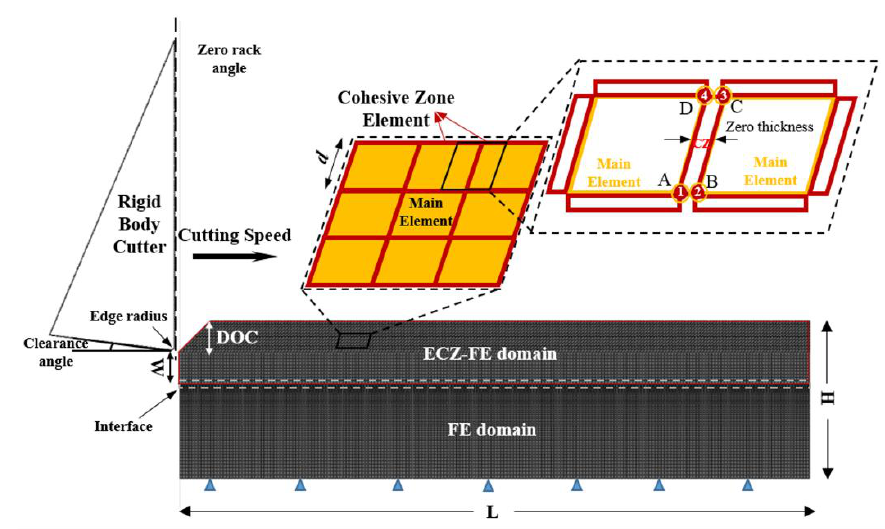
Figure 1. Schematic of embedded cohesive zone–finite element method (ECZ–FEM) model configuration, boundary conditions, and element arrangements.